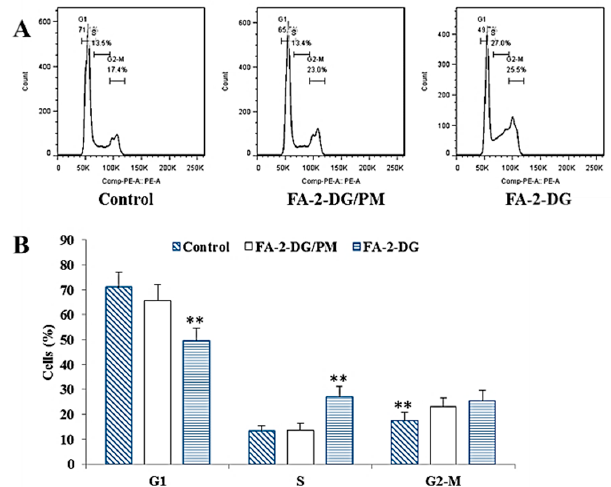
Figure 4. The effect of FA-2-DG on cell cycle regulation in SKOV-3 cells. ( A ) The cells were treated with the blank control and the other two groups of compounds at concentrations of 400 μ M for 24 h, stained with propidium iodide (PI) and then subjected to flow cytometry analysis to determine the cell distribution at each phase of the cell cycle. The representative results from three independent experiments are shown. ( B ) The results are expressed as means ± SD of three independent experiments. Significant difference from the control was determined by using Student’s t -test (** p <